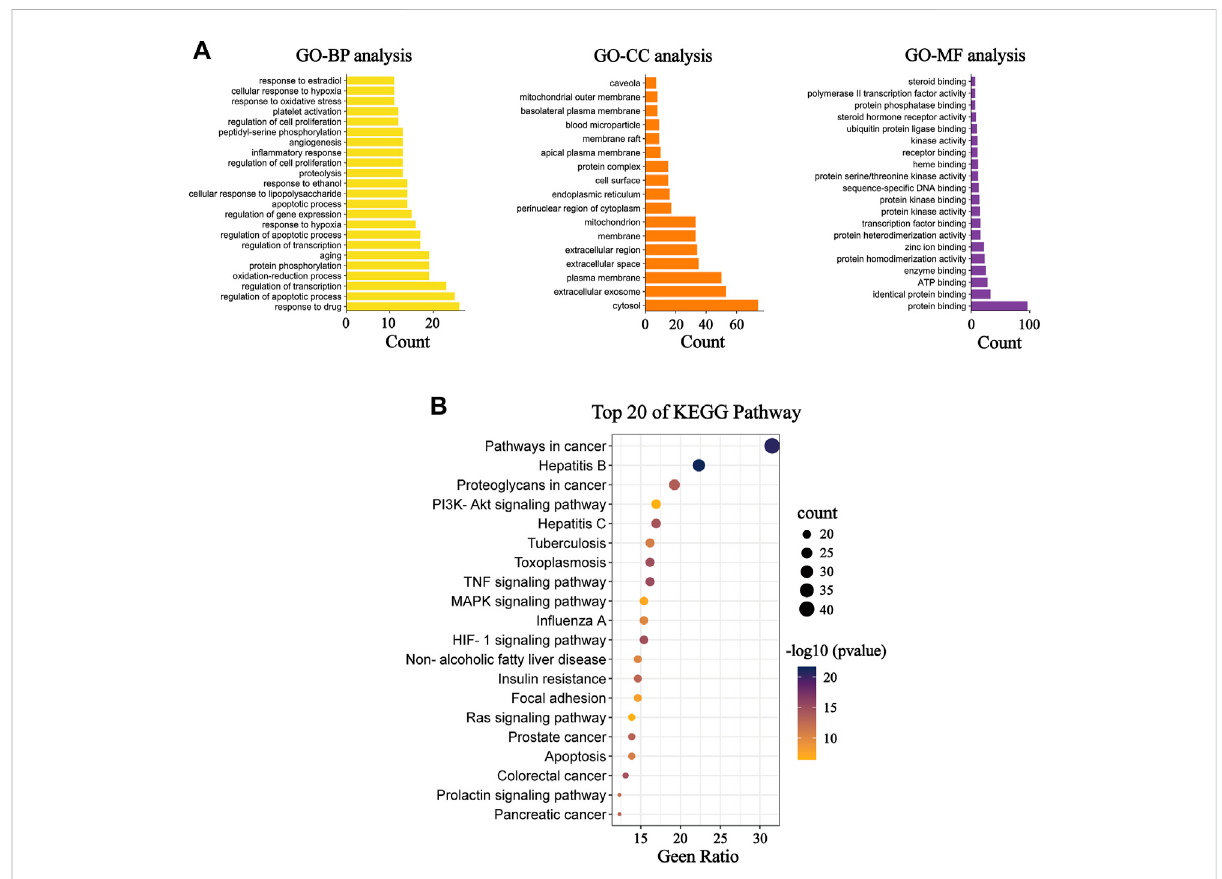
FIGURE 3 GOandKEGGfunctionalanalysis. (A) DiagramofGOBPanalysis;diagramofGOCCanalysis;anddiagramofGOMFanalysis. (B) KEGGpathway enrichment